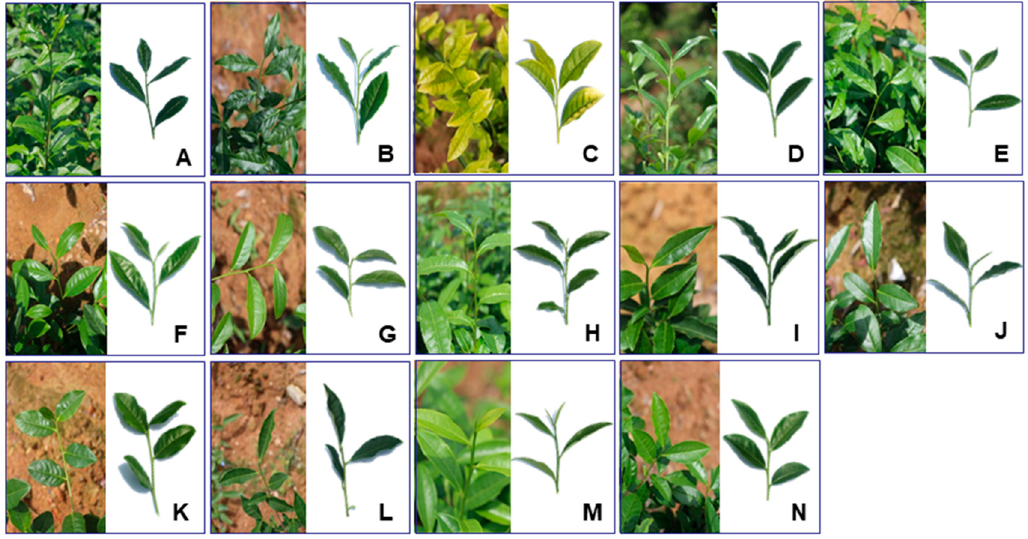
Figure 1. Leaf phenotypes of 14 Wuyi Rock tea cultivars. ( A ) ‘Dahongpao’ (DHP); ( B ) ‘Tieluohan’